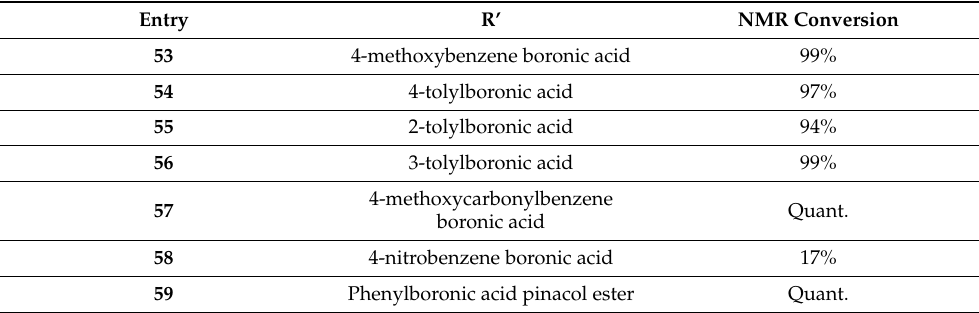
Table 7. Substrate scope investigating the effect of changing the boronic acid coupling to 4 – bromo- acetophenone.